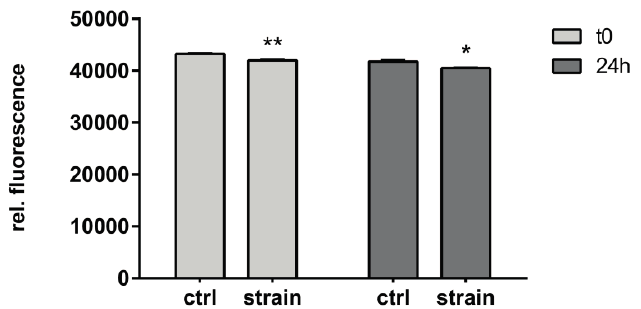
Figure 6. Effect of strain on cell viability. C-28/I2 chondrocytes were stretched (8%) for 12 h with cyclic square waveforms at 1 Hz. Cell viability was assessed using CellTiter Blue ® directly after straining ( t ) or 24 h later, and is expressed as relative fluorescent 0 signal (560 nm/590 nm ratio). Unstrained controls (ctrl), stretched cells (strain). * and ** indicate significance levels of p ≤ 0.05 and p ≤ 0.01, respectively, n = 3.